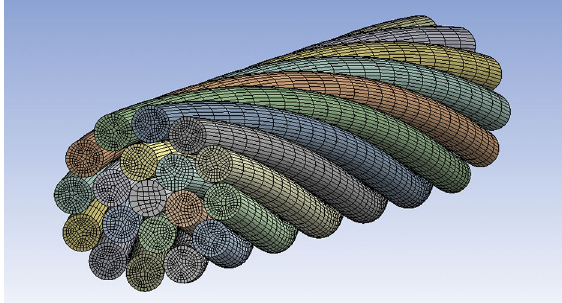
Fig. 5. 3D finite element model of the 1 × 19 wire rope core